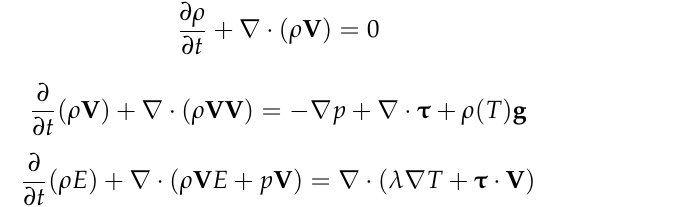
Table 1. Properties of calcium chloride solutions at 0 ◦ C. Property